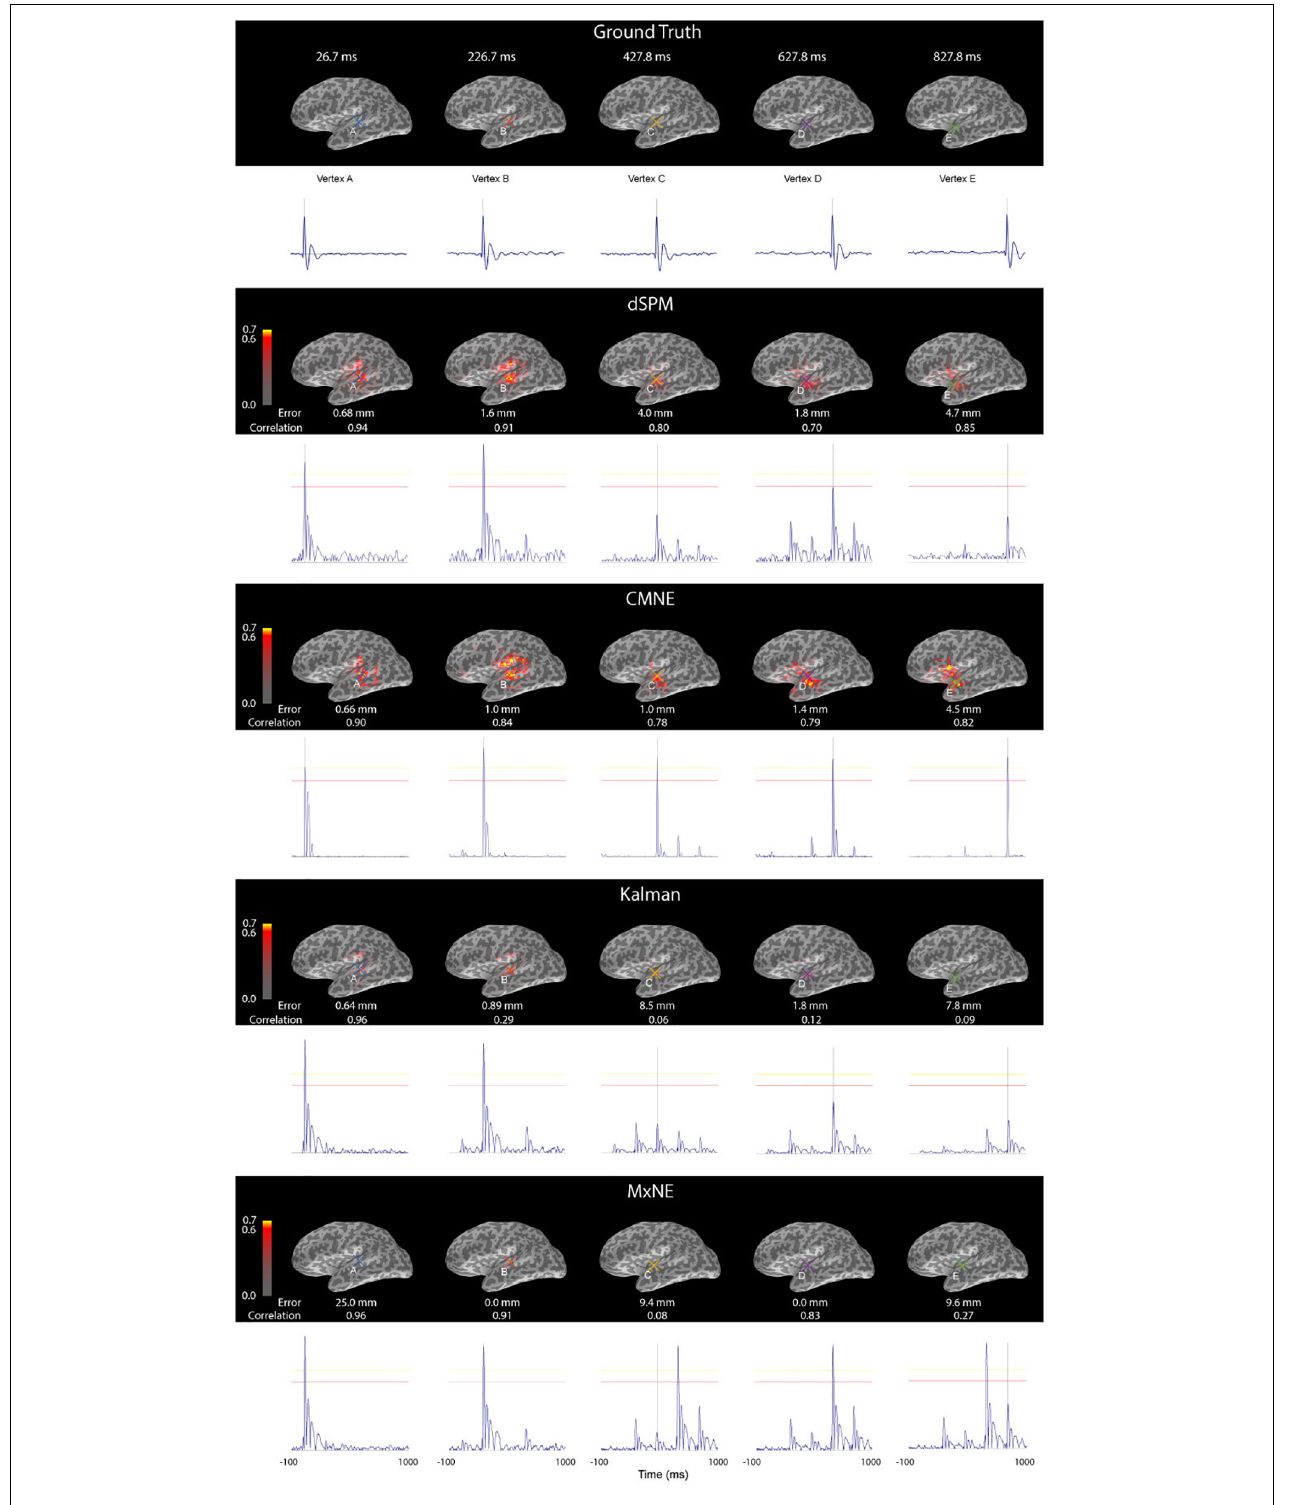
FIGURE 6 | Source activation (first row), dSPM estimate (second row), CMNE estimate (third row), Kalman estimate (fourth row) and MxNE (fifth row) of simulated data displayed over an inflated cortex at the time of peak activations of dipoles (A-E) along with the time traces of the reconstructured dipoles that had the largest amplitudes at the time of peak activations (marked A-E). The results are based on an average of 20 epochs. All estimates were rectified and normalized to their peak value.